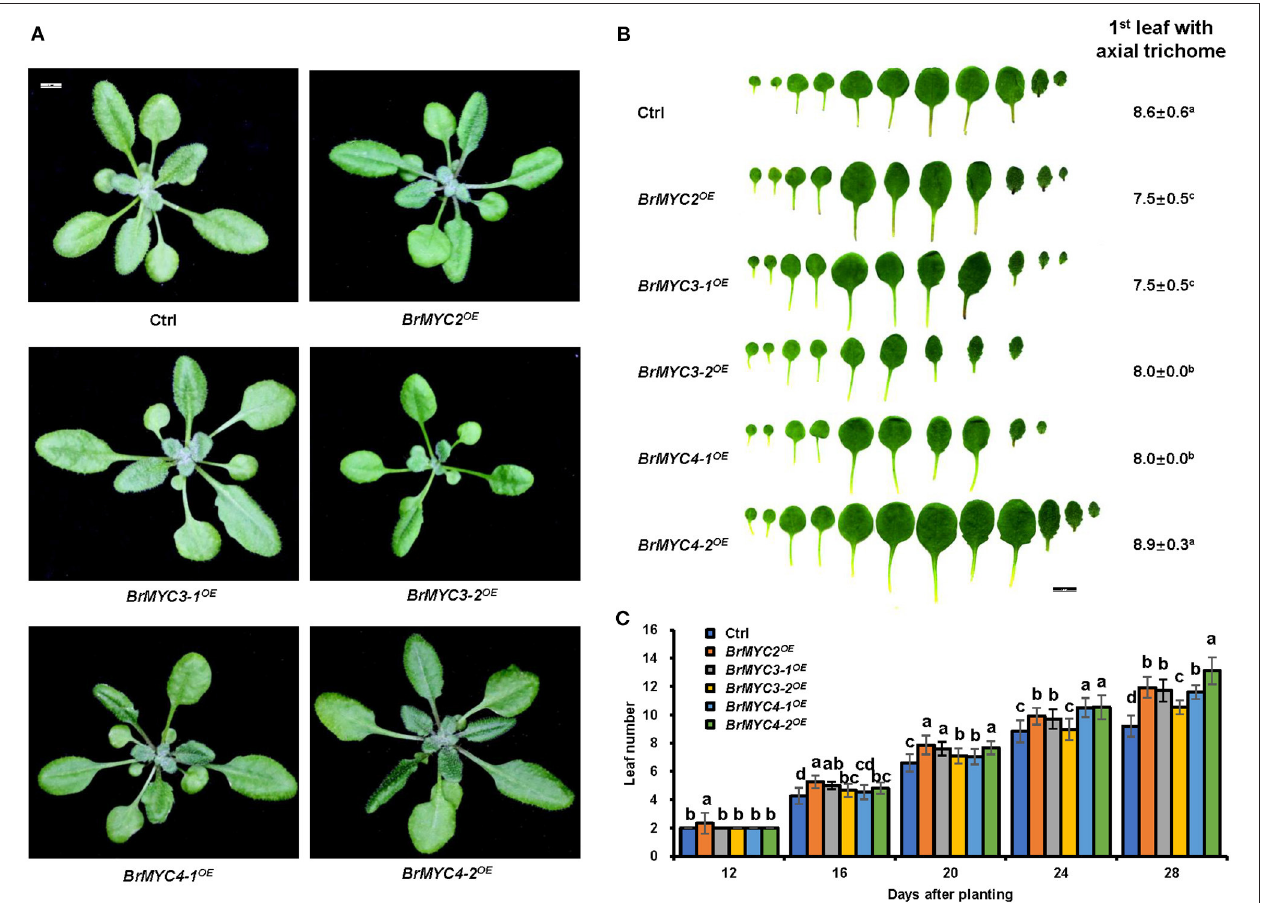
FIGURE 6 | The effect of BrMYC2/3/4 expression on the growth of Arabidopsis . (A) Phenotype of 28-day old transgenic Arabidopsis . (B) Phenotype of leaf shape and abaxial trichome of fully expanded rosette leaves. The average numbers of the first leaf showing abaxial trichomes are presented. Different superscript letters on the numbers denote a significant difference between the transgenic lines. (C) Leaf initiation rate of transgenic Arabidopsis in short days. Leaf numbers were scored at 12, 16, 20, 24, and 28 days after planting. Transgenic lines are Ctrl, BrMYC2 OE , BrMYC3-1 OE , BrMYC3-2 OE , BrMYC4-1 OE , and BrMYC4-2 OE . Data are shown as mean ± SD from three independent biological replicates. ANOVA was used for statistical analysis, followed by Tukey’s multiple comparison test ( p < 0.05). Bar = 1cm.